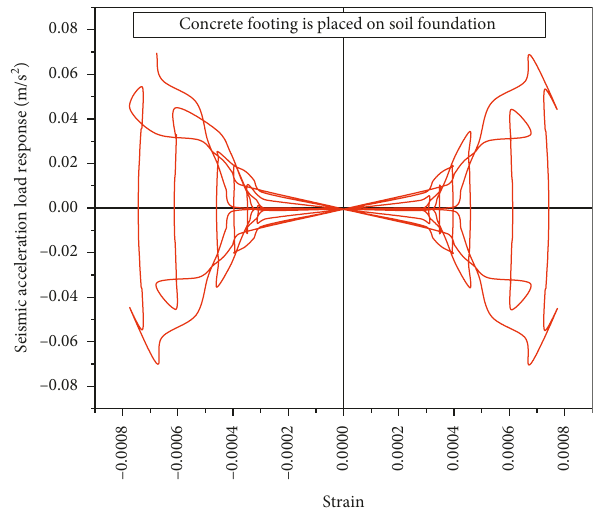
Figure 8: Seismic acceleration load response vs strain at the base of a concrete footing, during concrete footing-soil foundation